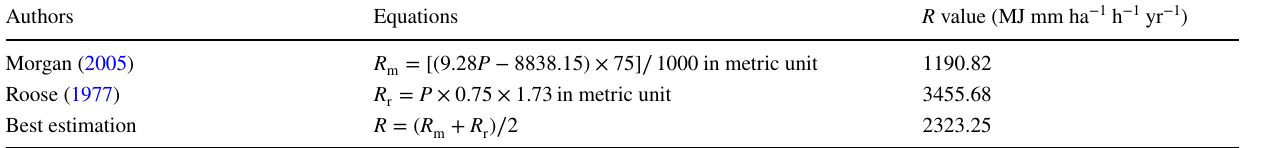
Table 3 Comparison of rainfall erosivity factor (R) calculated using different methods Authors